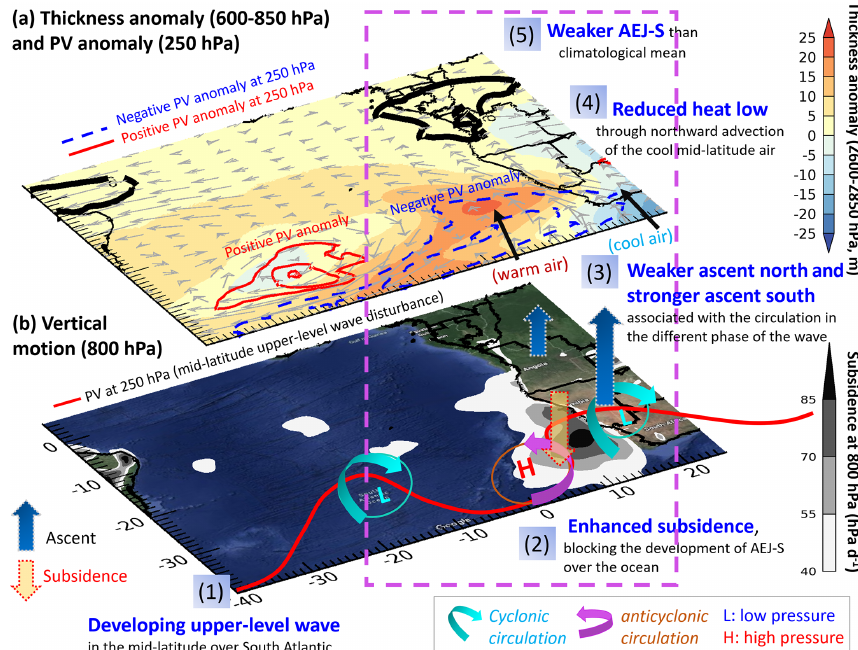
Figure 11. Schematics of the upper-level disturbance and associated circulations, leading to the change in a vertical motion, reduction in the heat low through northward advection of the cool mid-latitude air, resulting in the weaker AEJ-S in August 2017 over the land north of 10 ◦ S. The enhanced subsidence also contributes to preventing the development of AEJ-S over the ocean. (a) Map of 250hPa PV anomaly (dashed contour; potential vorticity unit – PVU; the blue dashed (red solid) line represents the negative (positive) PV anomaly), thickness anomaly (Z600hPa–Z850hPa; shading; meters), and 250hPa horizontal wind anomaly (gray arrow; ms − 1 ) overlain by AEJ-S (zonal wind isotach at 700hPa; ms − 1 ). (b) Subsidence (positive values from omega at 800hPa; hPad − 1 ) is plotted on © Google